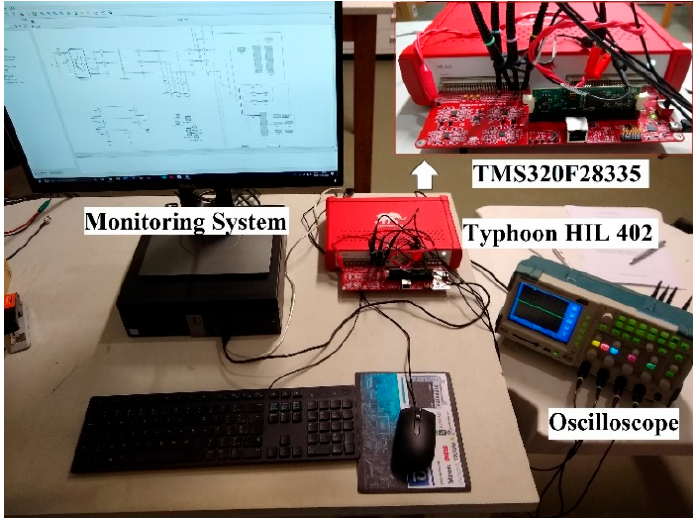
Figure 5. Test bench setup for experimental results.